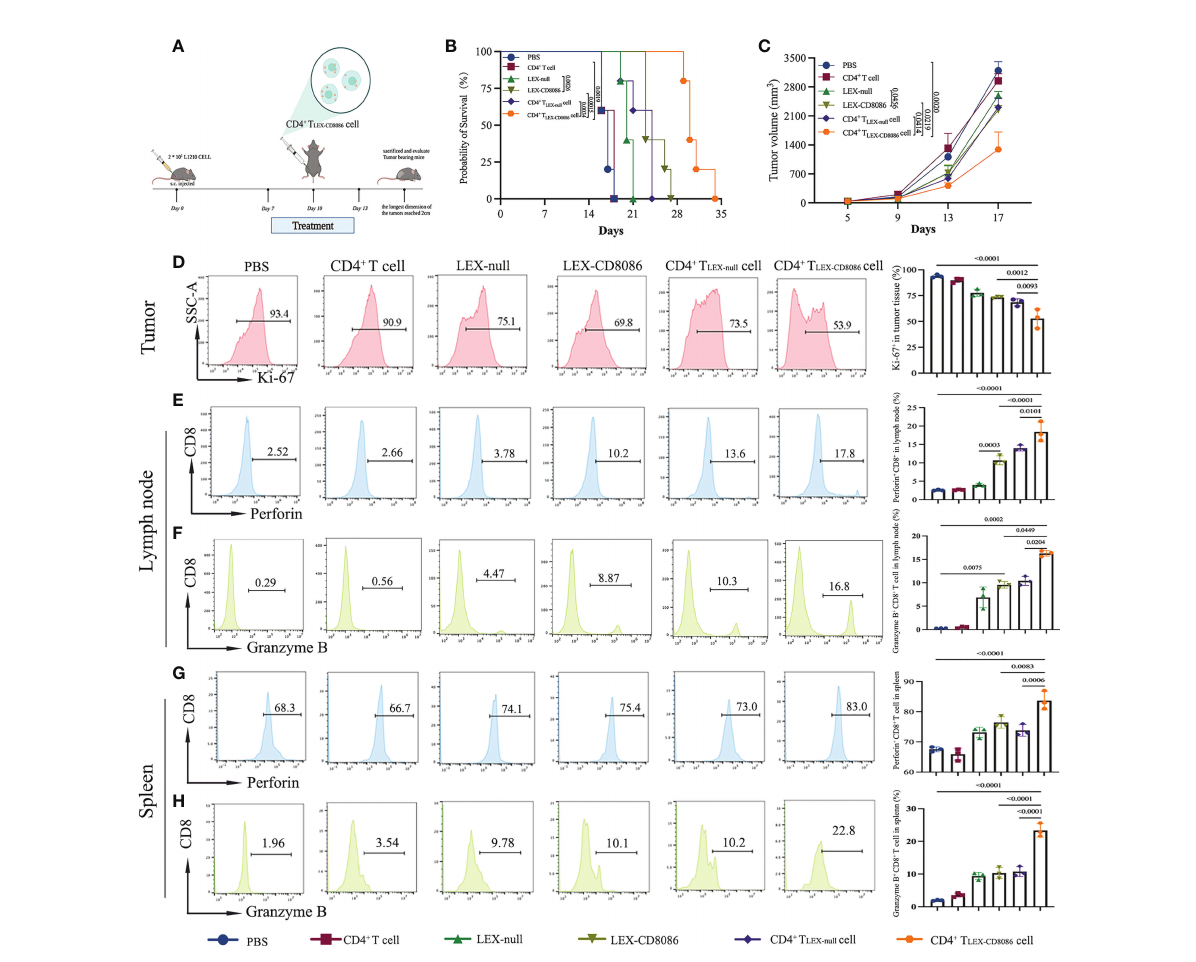
FIGURE 6 CD4 + T LEX-CD8086 cell immunization induces potent anti-leukemia therapeutic immunity. (A) Schematic protocols of the experimental design in the animal study. DBA/2 mice were injected with L1210 cells. When the tumors became palpable (generally, on the 7th day), the mice were s.c. injected with different vaccine formulations, including CD4 + T cells, LEX-nulls, LEX-CD8086, CD4 + T LEX-null cells, and CD4 + T LEX-CD8086 cells on Day7, 10, and 13. (B) Mice survival. (C) Tumor growth. (D) Analysis of Ki-67 expression in tumor tissues after the indicated treatments (Left). Quantitative analysis of the results of Ki-67 expression (Right, n=5). (E, F) Analysis of expression of Perforin and Granzyme B of CD8 + T in the lymph nodes from the mice by fl ow cytometry (Left). Quantitative analysis of expression of Perforin and Granzyme B of CD8 + T cells in the lymph nodes (Right, n=5). (G, H) Analysis of expression of Perforin and Granzyme B of CD8 + T cells in the spleens of the mice by fl ow cytometry (Left). Quantitative analysis of expression of Perforin and Granzyme B of CD8 + T cells in the spleens (Right, n=5). All data in this fi gure are presented as means ± SD. The survival data of the mice were analyzed by the log-rank test and other results were analyzed by